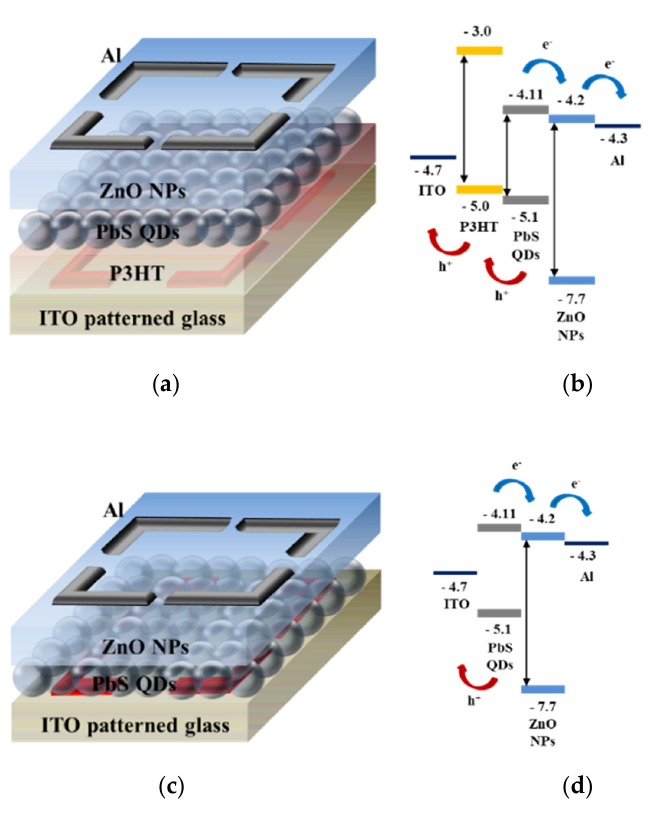
Figure 1. ( a ) Structure and ( b ) energy band diagram of PbS SWIR photodetector without P3HT and ( c ) structure and ( d ) energy band diagram of PbS SWIR photodetector with